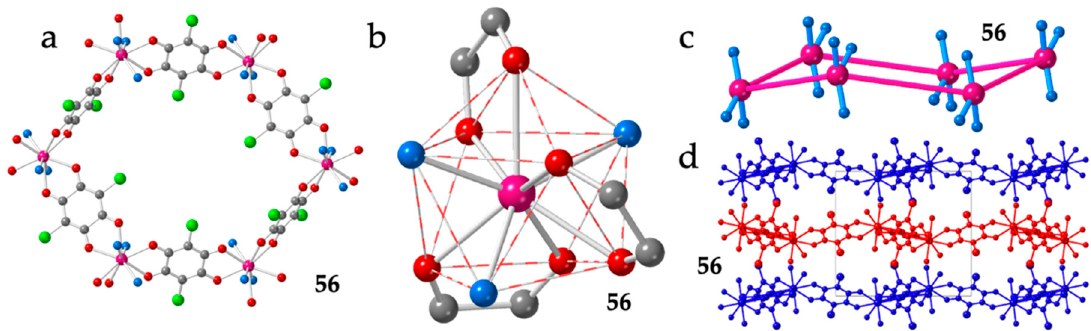
Figure 8. Structure of compound 56 . ( a ) View of one hexagonal ring. ( b ) View of the CSAPR-9 coordination geometry around the Er(III) ion. ( c ) Side view of one hexagonal ring showing the position of the three oxygen atoms of the fma molecules coordinated to each Er(III) ion. ( d ) View of three consecutive layers. Colour code in ( a ‐ c ): Ln = pink, C = grey, O anilato = red and O solvent = blue.